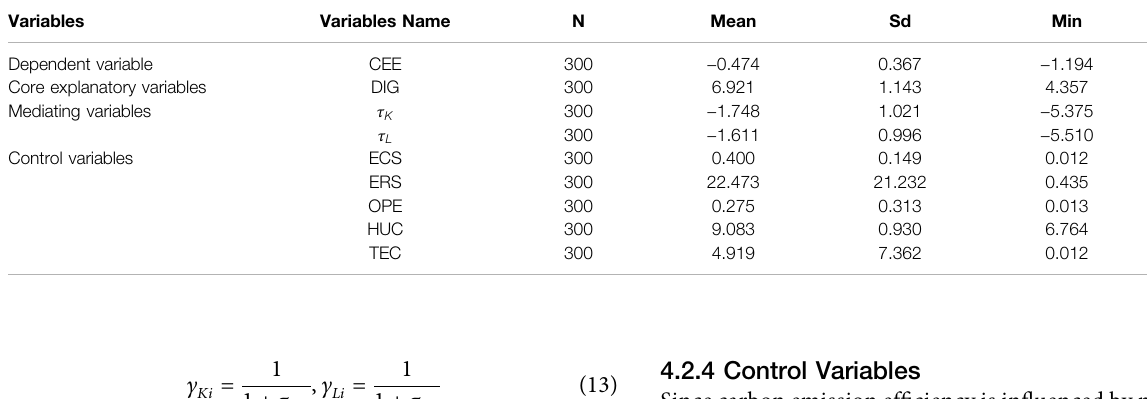
TABLE 4 | Descriptive statistics of